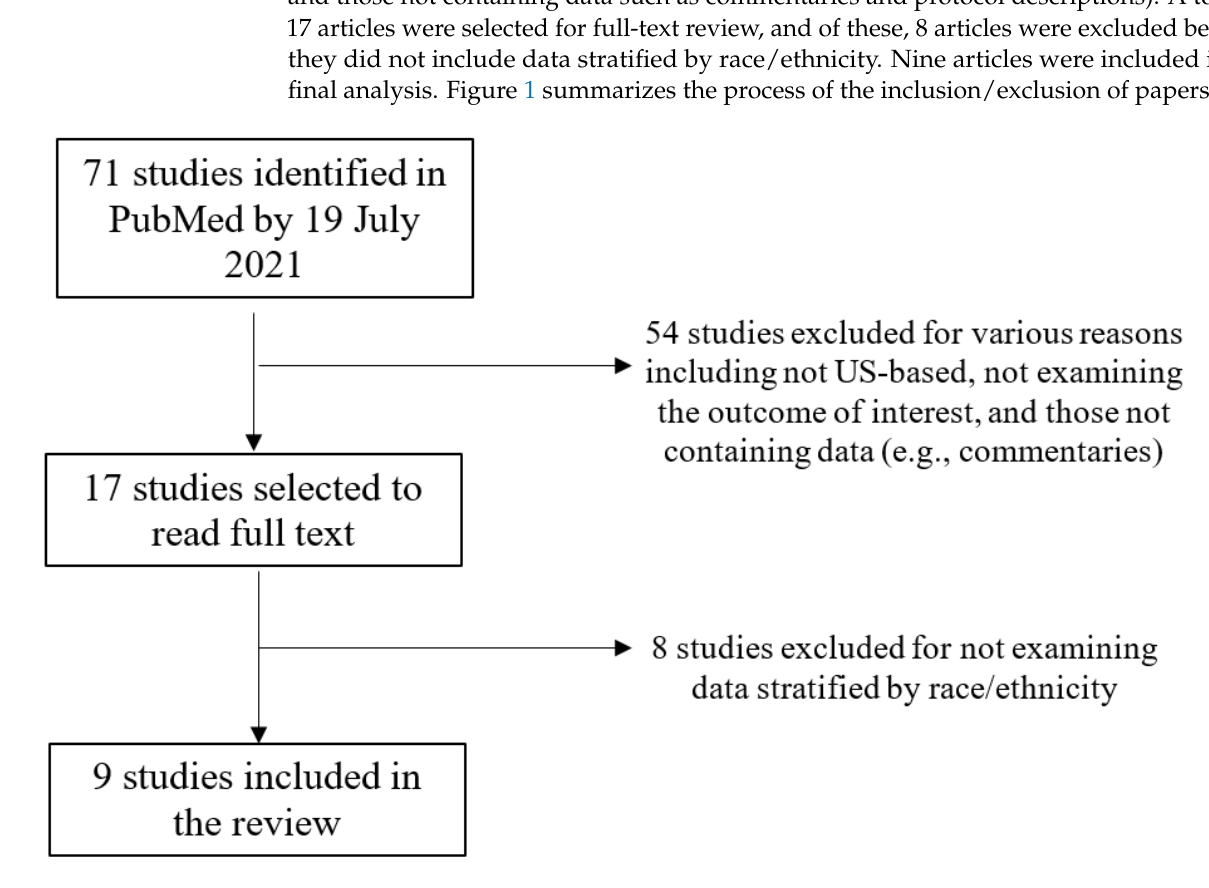
Figure 1. Flowchart of study inclusion.